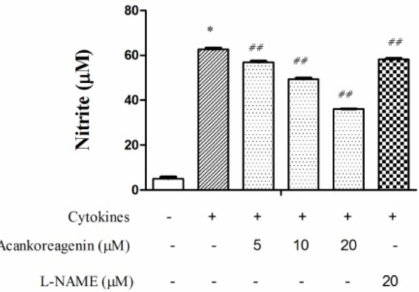
Figure 4. Effects of acankoreagenin on the cytokine-induced NO protection in the RIN-m5F cells.RIN-m5F cells were pretreated with the indicated concentrations of samples for 1 h and then exposed to IL-1 β (10 ng/mL) and IFN- γ (100 ng/mL) for 24 h. Then the level of nitrite production was determined. * p < 0.05 versus vehicle-treated control; ## p < 0.01 versus cytokine-treated group. Bars indicate SEM ( n = 3).